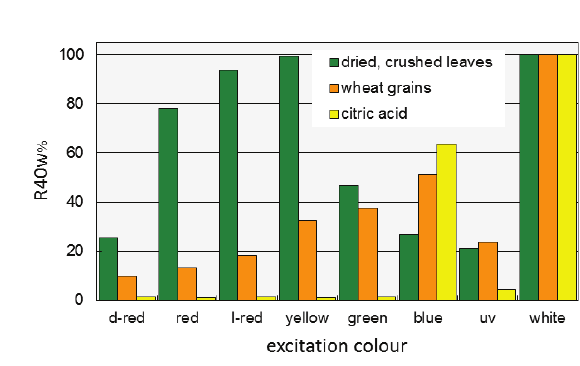
Figure 4: Stages of ripening of apples (n=60, 12 apples at each harvest date). The fruits became more fruit-specific with increased time of harvest (broadband spectrum, more emission after yellow than after blue, represented by R40ye/bl), while the seeds became more seed-specific (narrowband spectrum, low R40ye/bl values) (Bloksma et al.